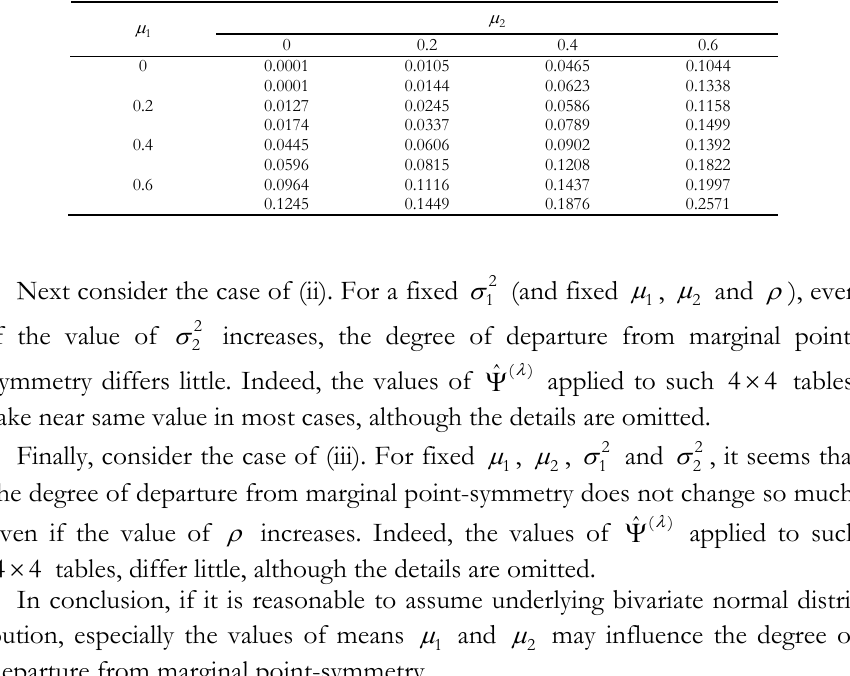
The values of (0) ˆ  (upper value) and (1) ˆ  (lower value) applied to 4 4  obtained from an underlying bivariate normal distribution with various